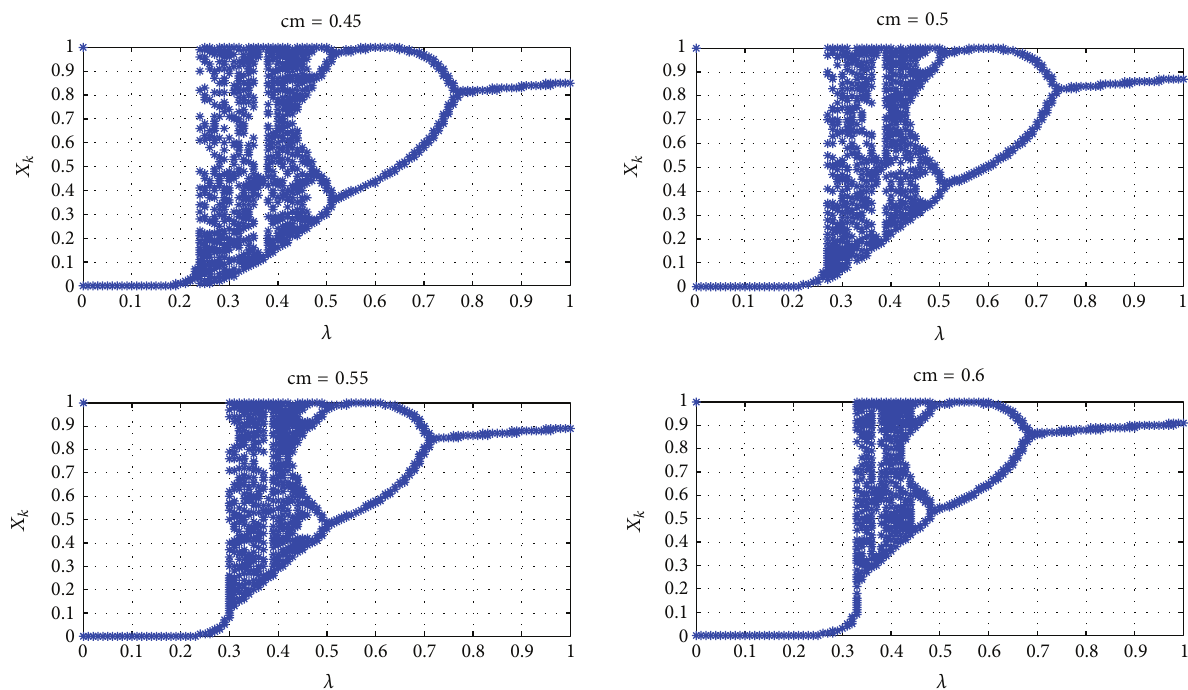
Figure 12: Bifurcation diagram using cm = 0.45, 0.50, 0.55, and